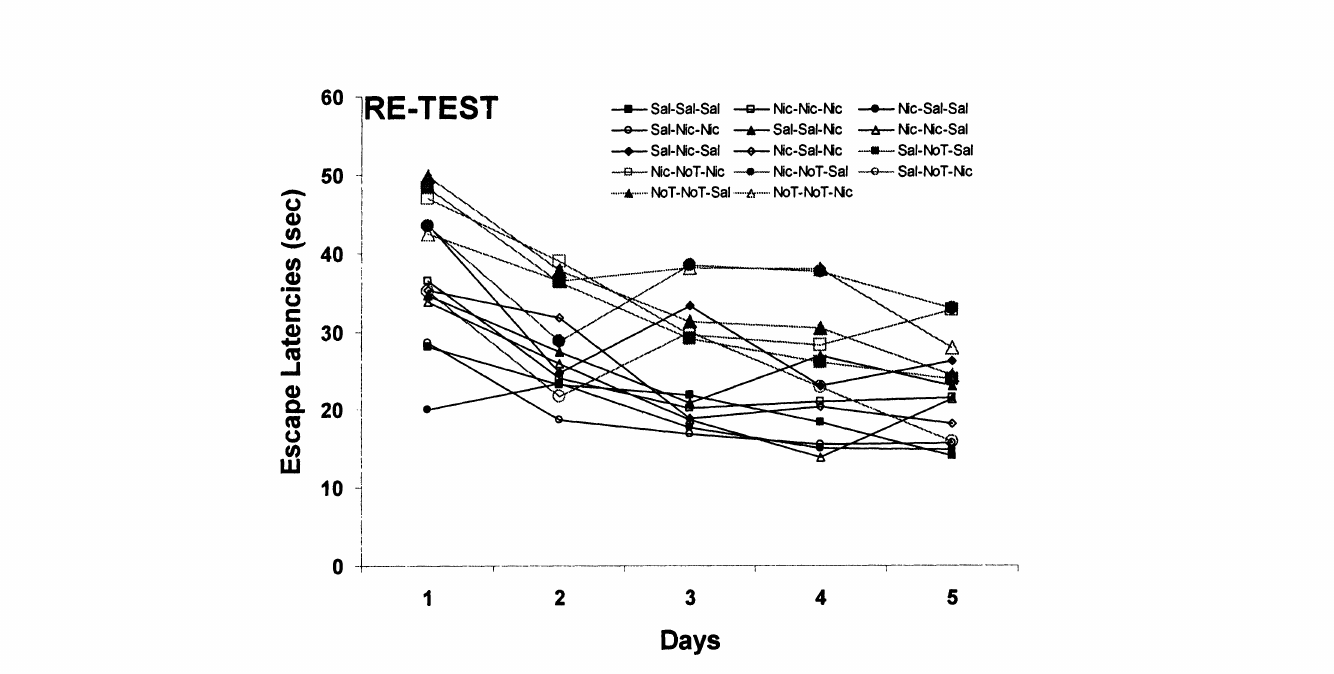
Fig. 3: Mean (+ SEM) daily escape latencies (averaged over four trials/day) of NMRJ mice at 10 months of age (re test phase). In this phase, mice assigned to 14 experimental groups were evaluated. Each group is named according to the drug treatment in each phase of the longitudinal sttdy: nicotine (Nic), physiological saline (Sal) and no drug treatment or behavioral manipulation (Not). In this re-test phase, 7 groups received saline and 7 groups received nicotine, as indicated with the third abbreviation used for the legend of each